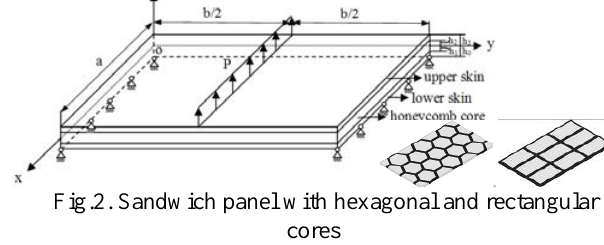
Fig.2. Sandwich panel with hexagonal and